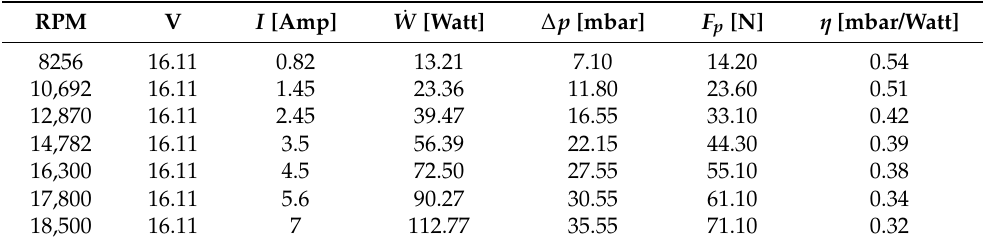
Table 4. Test rig measurements for the